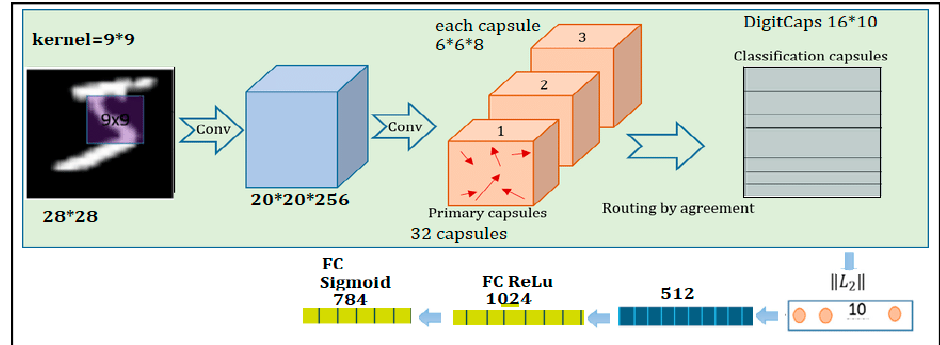
Figure 6. Capsule network architecture-MNIST.